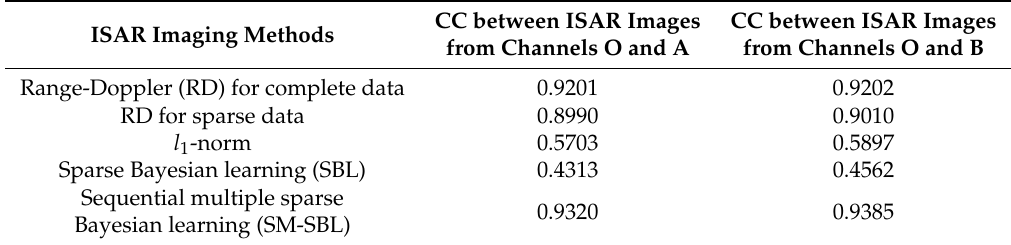
Table 2. Correlation coefficients (CC) of multi-channel inverse synthetic aperture radar (ISAR) images for gap missing sampling